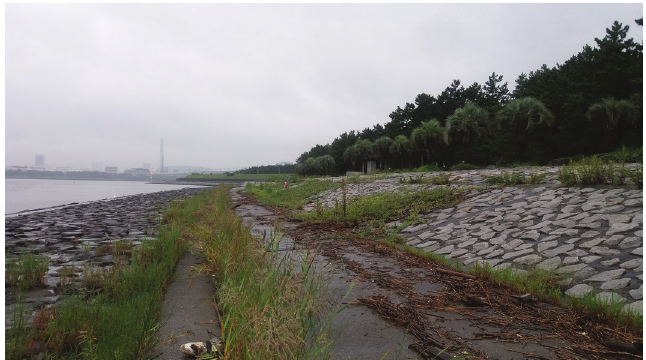
Fig. 4. Flat terrace on the riverside slope of a flood defense em- bankment at Kasai Rinkai Park at the mouth of the Edogawa River in Tokyo Bay. The terrace is accumulating vegetation, including Aster tripolium , a rare and declining species in the Bay. Photo by T. Gardiner.